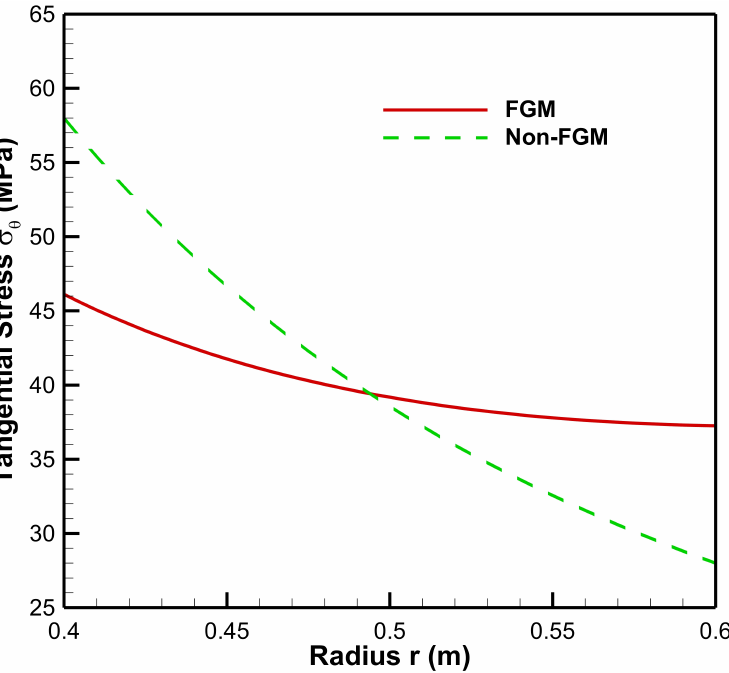
Figure 12. Tangential Stress along the radius of the cylinder under internal pressure, P a = 50 MPa and external pressure, P b = 20